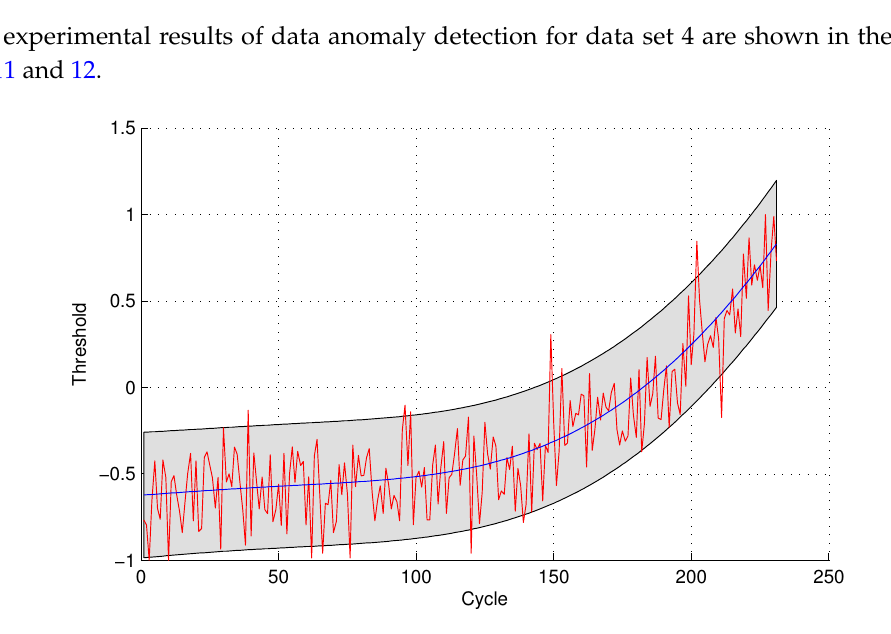
Figure 11. Anomaly detection for sensor data set 4 with GPR for the quantitative sensor